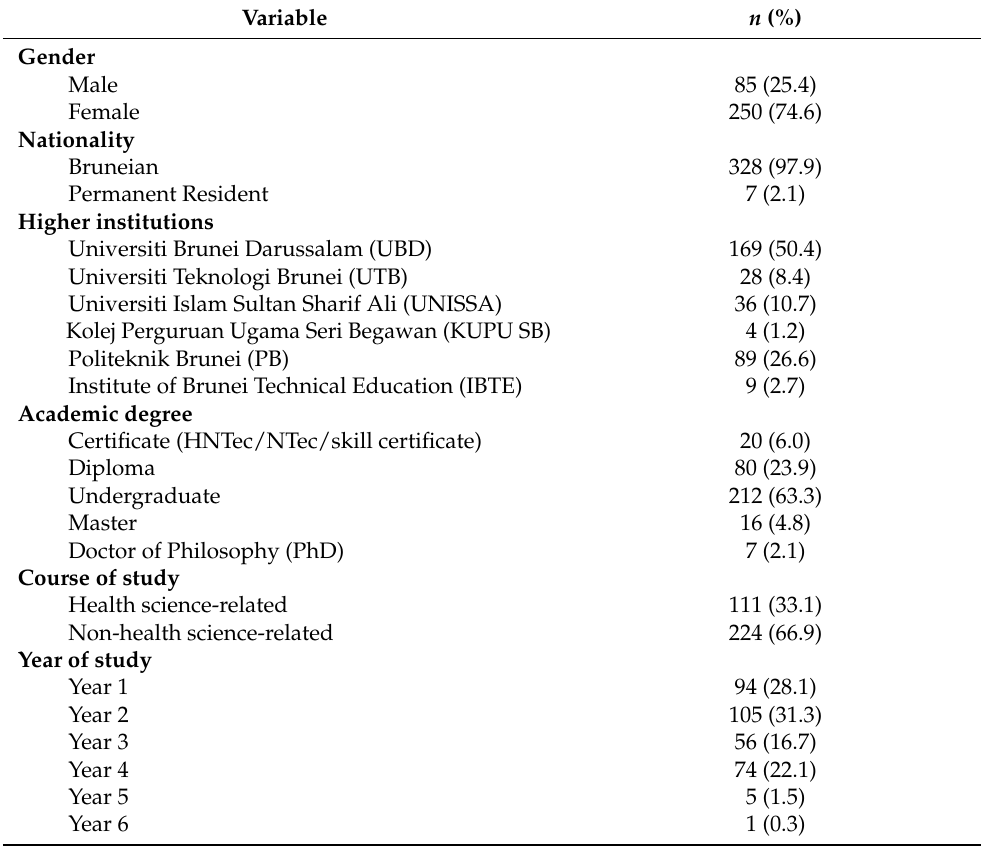
Table 1. Demographic characteristics of study sample ( n =